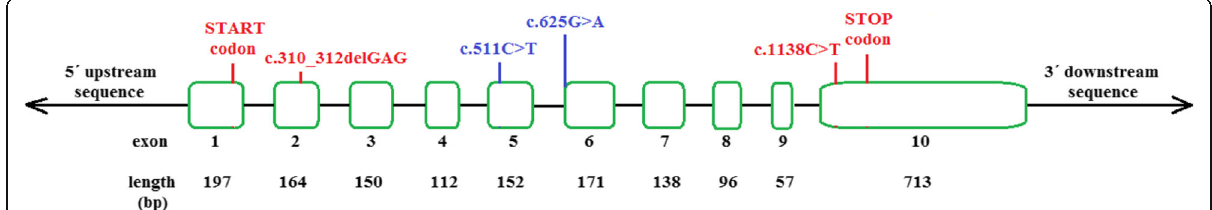
Fig. 1 The structure of the ACADS gene and the location of the frequent sequence variants. A schematic representation of the two frequent susceptibility variants c.511C>T and c.625G>A (blue), two pathogenic variants c.310_312delGAG and c.1138C>T (red), and their location in the coding sequence (green) of the ACADS